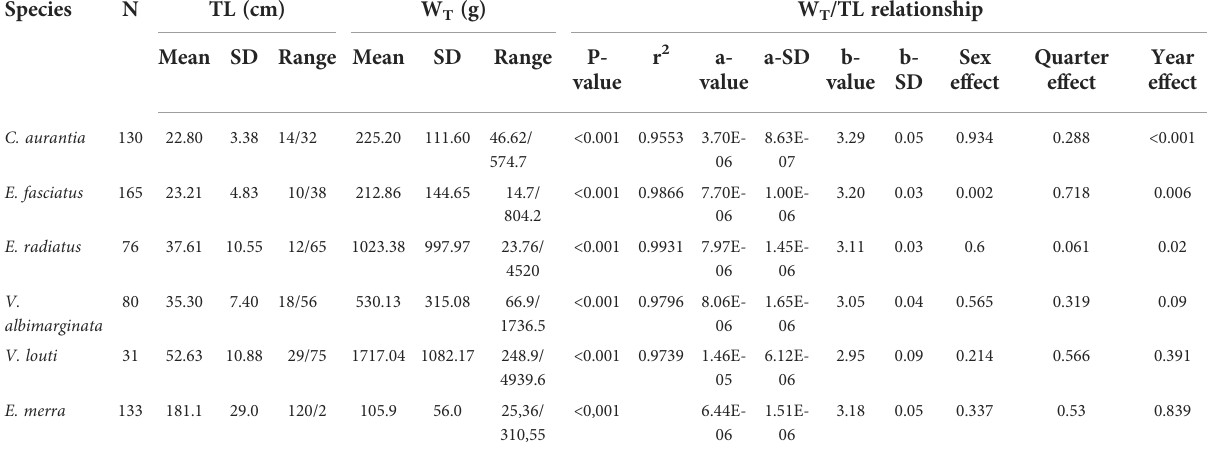
TABLE 1 Relationships between total length (TL; cm) and total weight (W T ; g) (Signi fi cance of this relationship, number of individuals, details of each measurement, parameters a and b; P-value of each potential effect). Species N TL (cm) W T